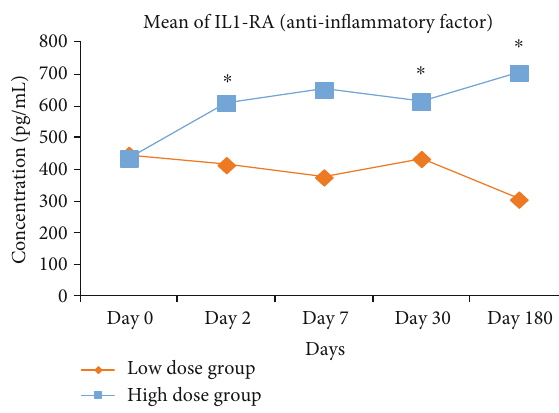
Figure 1: Serum level of IL1-RA measured in every follow-up visits for all subjects in the LD and HD group. The anti-in fl ammatory IL- 1RA was signi fi cantly elevated in HD subjects from day 2 to day 180 relative to baseline. Statistical signi fi cance of biomarkers between each follow-up visits was assessed by using the Wilcoxon signed- rank test. ∗ Signi fi cant value at p < 0 : 05 when compared with